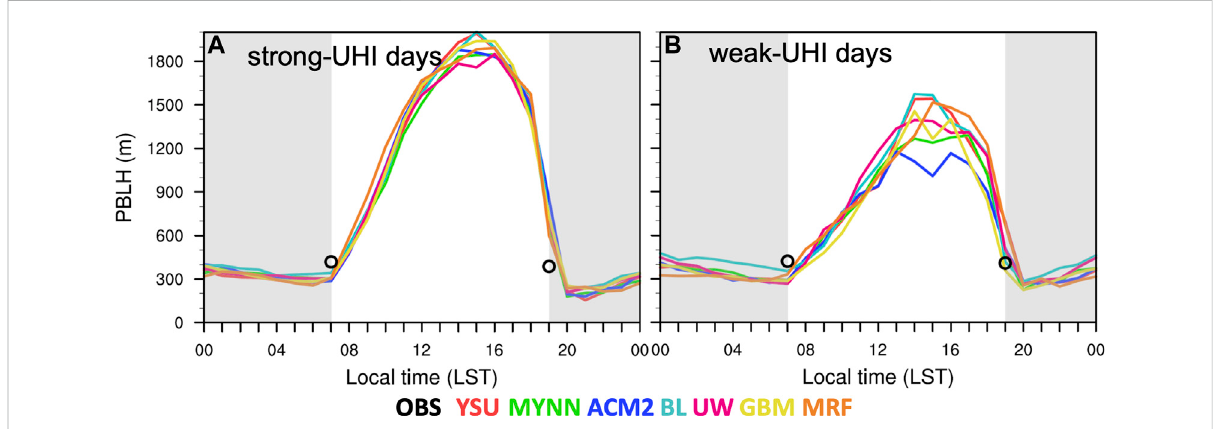
FIGURE 11 Comparisonsoftheobserved(blackcircle)andsimulated(coloredlines)PBLheightsatQingyuanstation(Figure1C)on (A) strong-UHIdaysand (B) weak-UHI days.